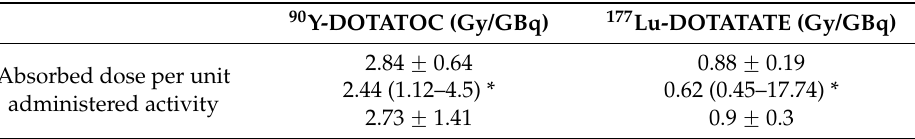
Table 1. Three examples of reported absorbed doses in kidneys per unit activity (Gy/GBq) with mean ˘ SD or median range (marked with an asterisk) following PRRT utilizing 90 Y-DOTATOC and 177